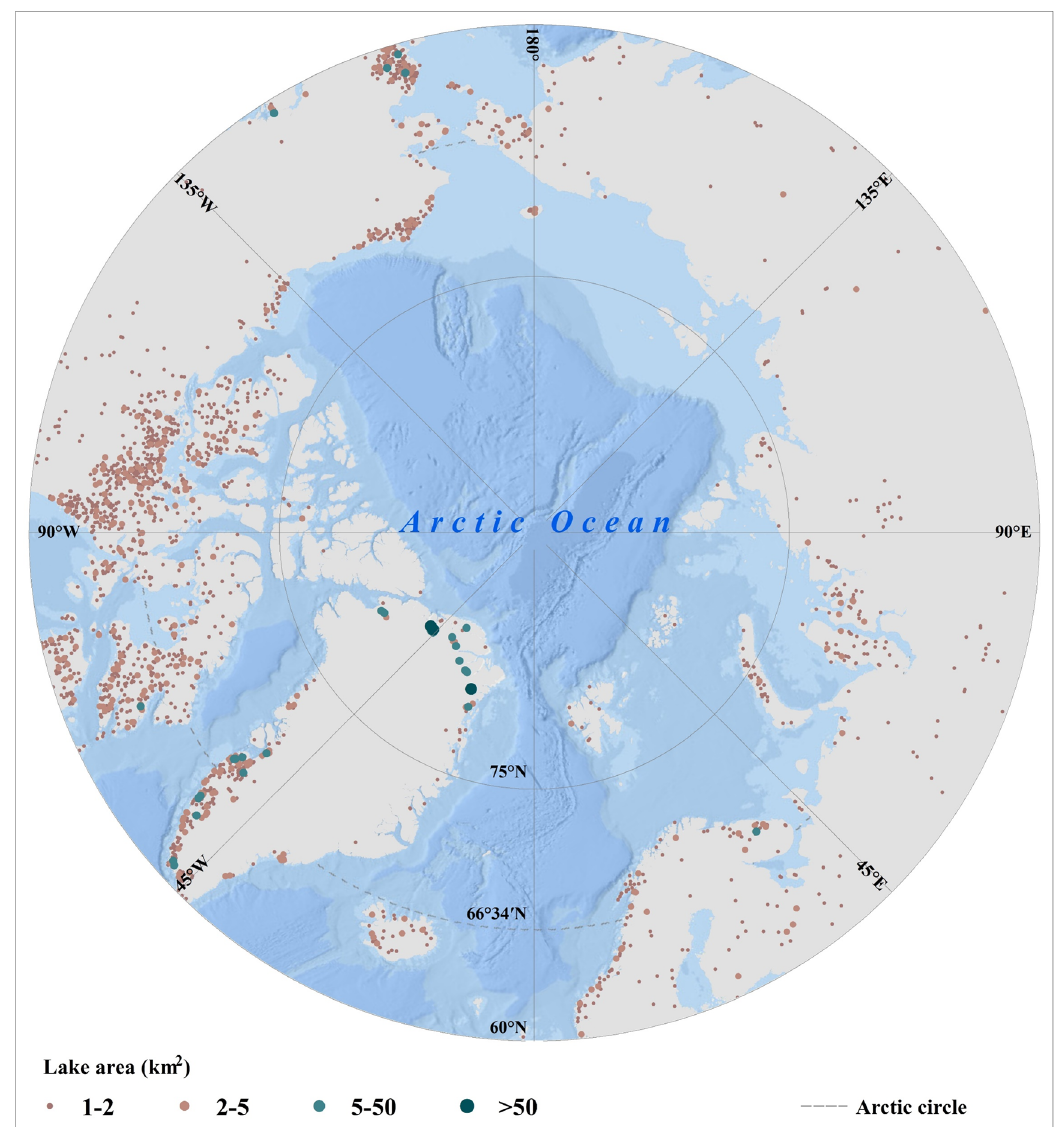
Figure 1. Global distribution of pan-Arctic lakes observed by the ICESat-2 in the HydroLAKES da- tabase. The right panel shows the number of observed lakes from different size groups in the Eastern and Western Hemispheres (NA and EURA).